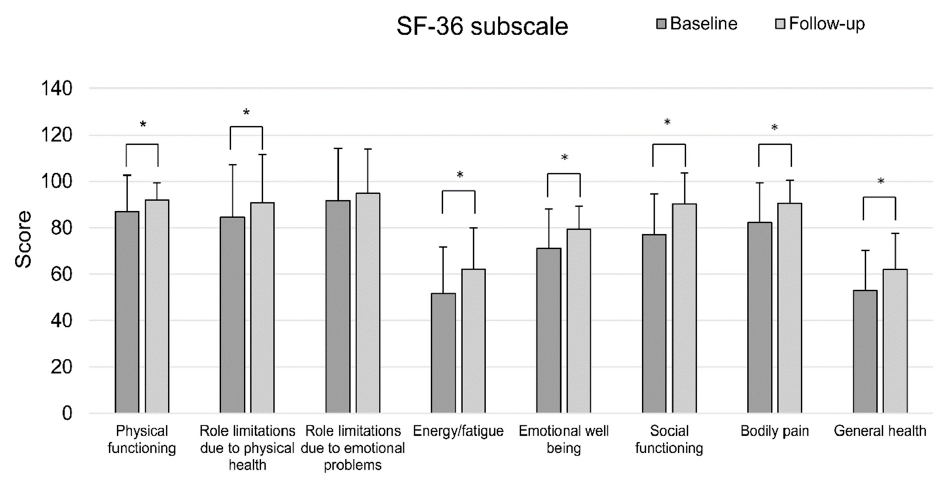
Figure 3. Comparison of the SF-36 scores in each domain between baseline and follow-up evaluation. * p < 0.05 is statistically significant.